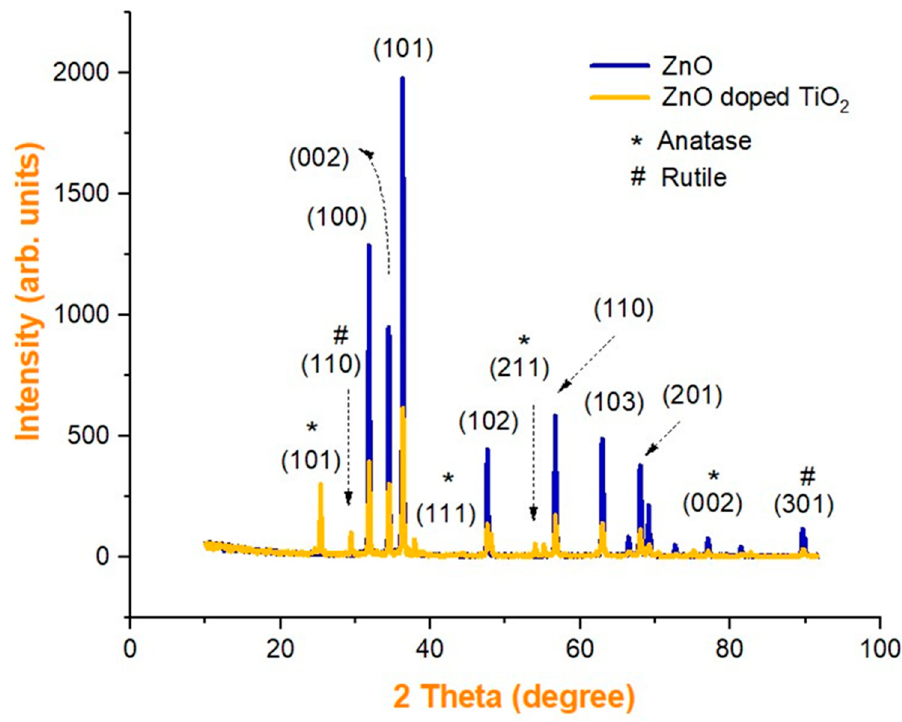
Figure 1. X-ray diffraction pattern of pure ZnO and ZnO-doped TiO 2 nanocomposites.